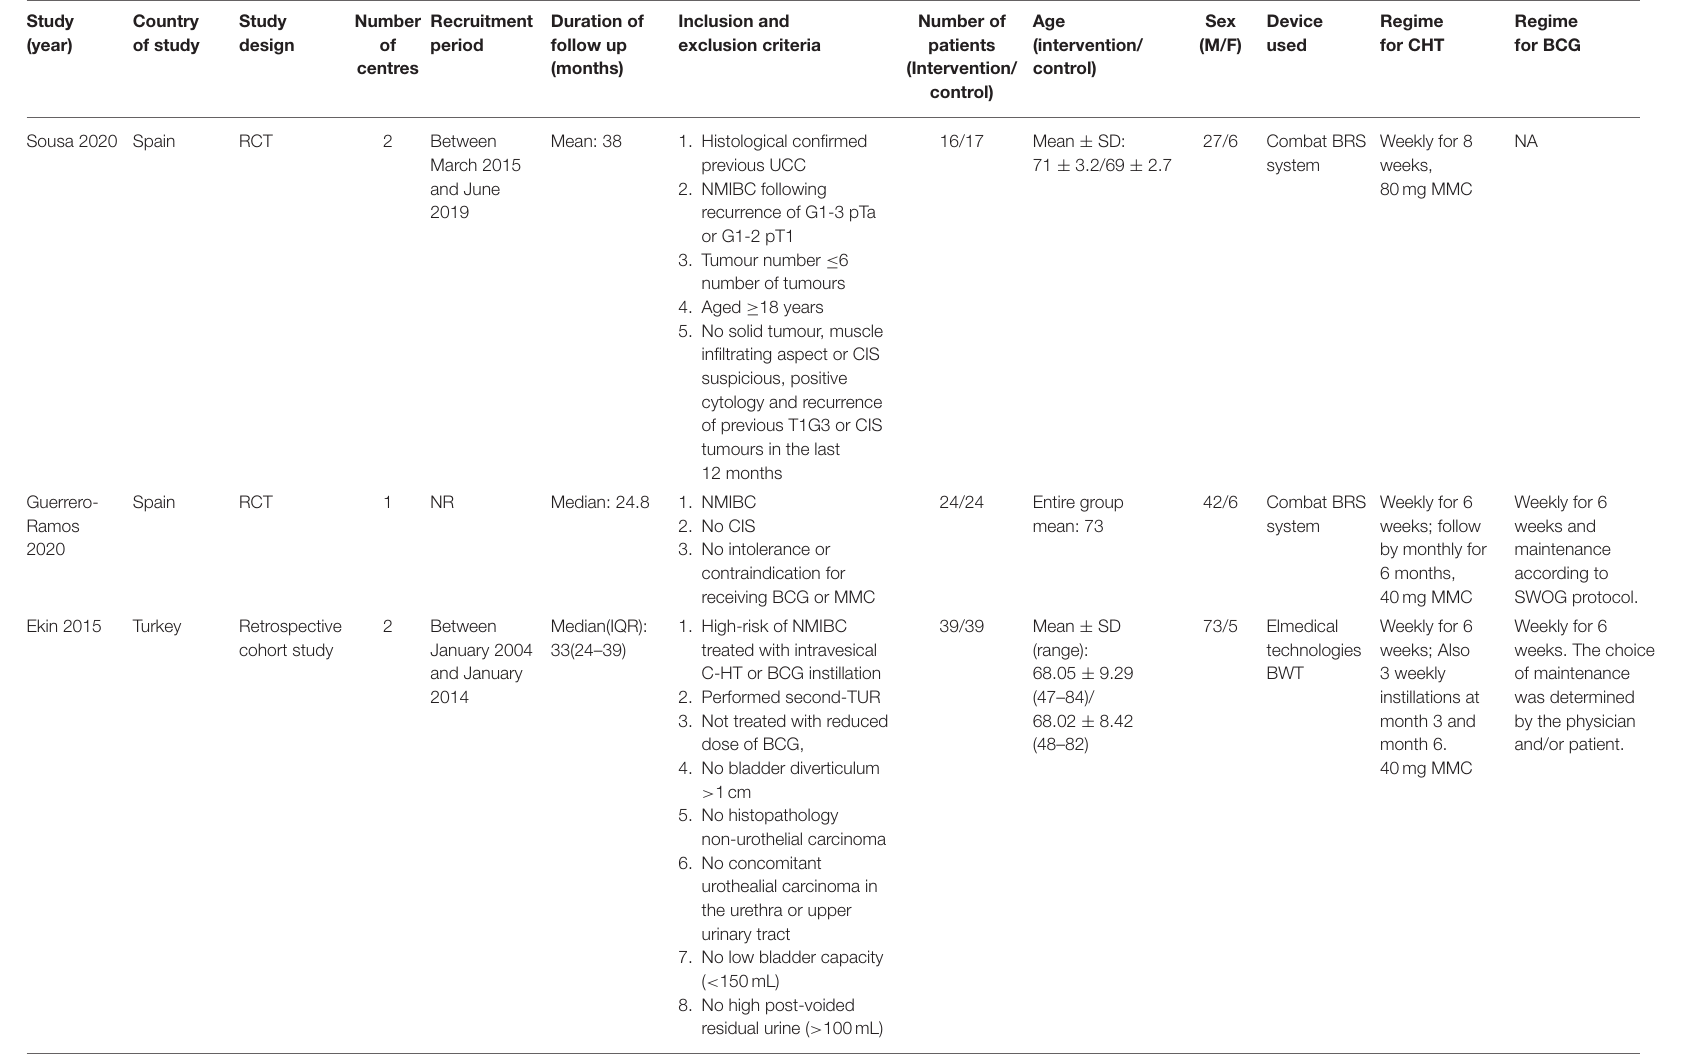
TABLE 1 | Characteristics of the included